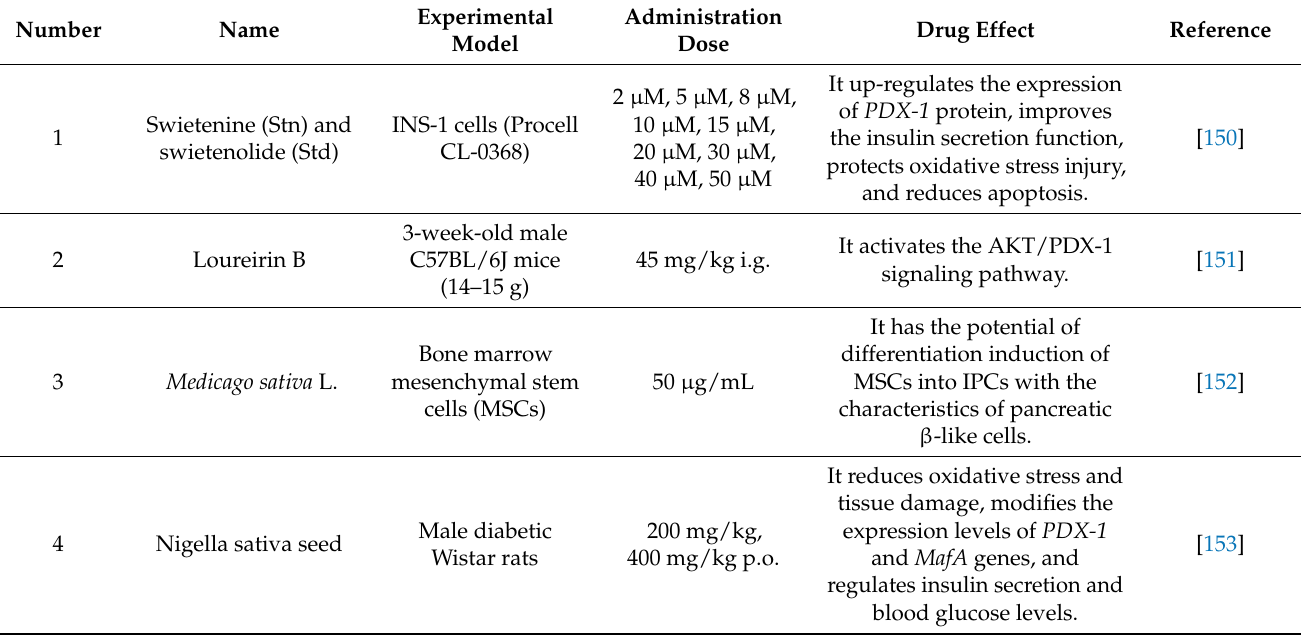
Table 2. Representative potential PDX-1 inducing drugs, small molecules and natural